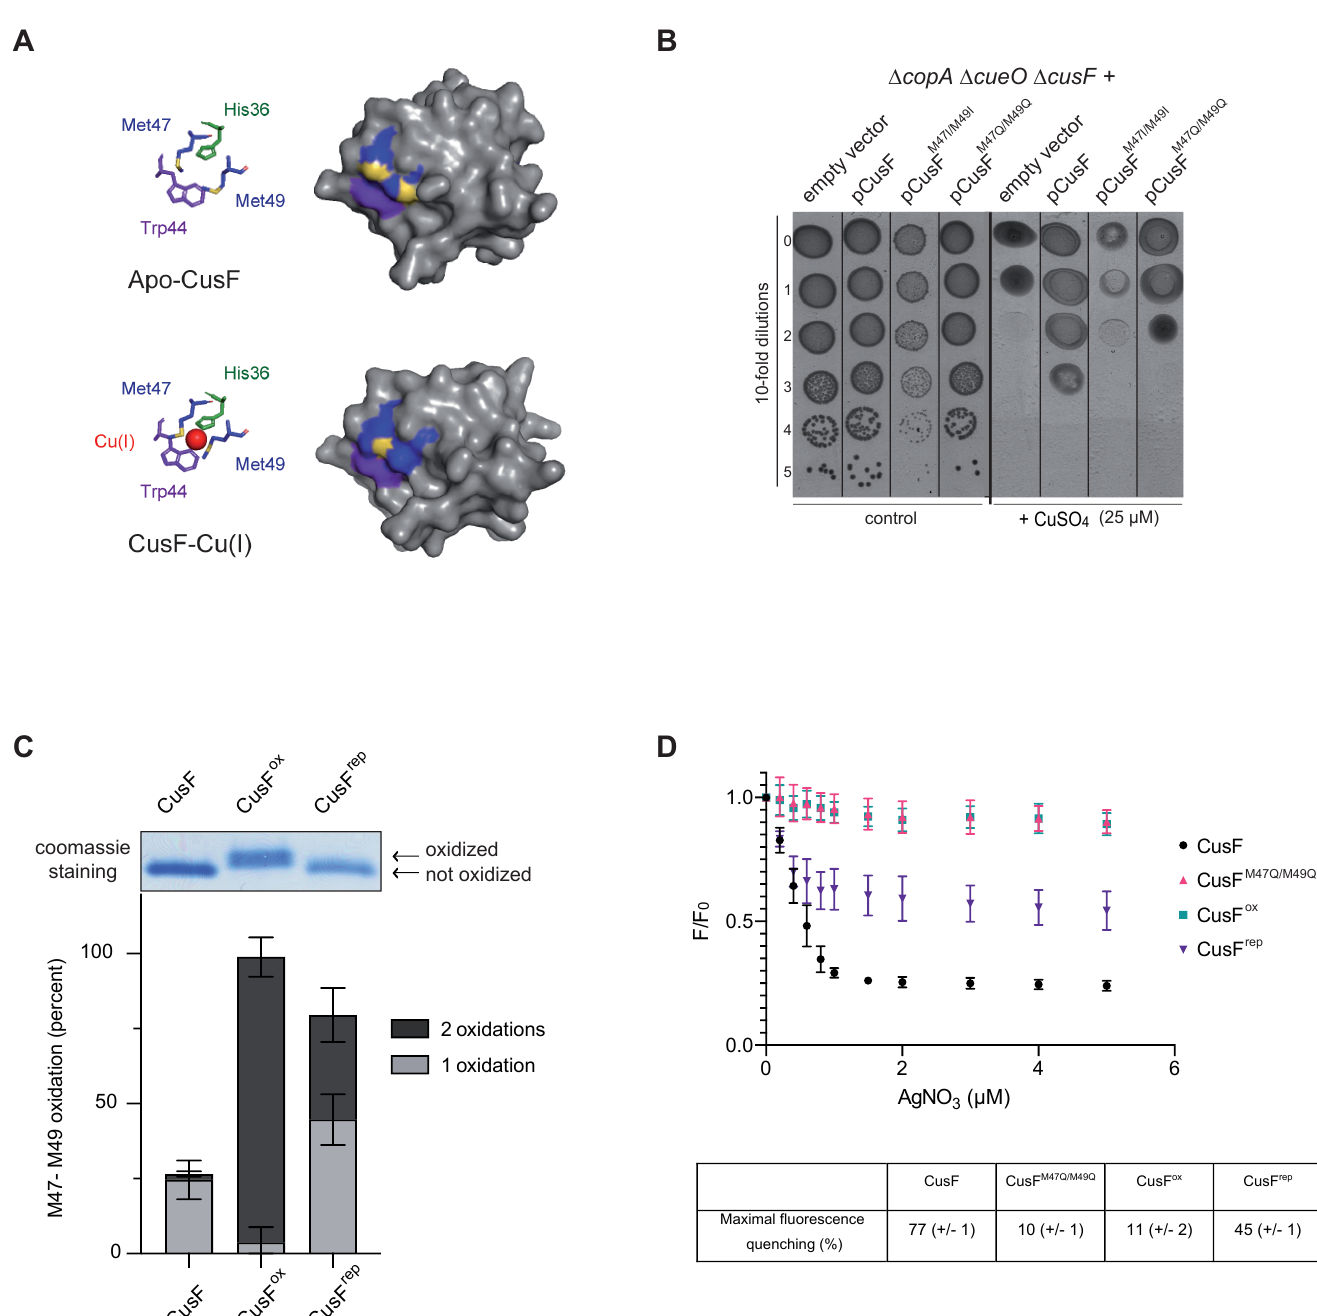
Fig 5. Methionine oxidation of CusF is deleterious. A) Aligned structures of the E . coli apo-CusF and CusF-Cu(I) adapted from PDB:1ZEQ and 2VB2 respectively [24,33] with stick and surface representations of CusF. Residues His 36 (green), Met 47, Met 49 (blue with sulphur atoms highlighted in yellow) and Trp44 (purple) are shown. The Cu(I) ion is shown in red. B) Plating efficiency of the Δ copA Δ cueO Δ cusF strain carrying empty vector, pCusF, pCusF M47I/M49I or pCusF M47Q/M49Q vectors onto M9 plates in the presence of CuSO 4 (25 μ M). The same protocol as described for Fig 2 was used, except plates contained ampicillin (50 μ g/ml) and IPTG (50 μ M). The images are representative of experiments carried out at least three times. C) Gel shift assay and mass spectrometry relative quantification by LFQ of the oxidation of Met47 and Met49. D) Silver binding analysed by quenching of intrinsic tryptophan fluorescence. Increasing concentrations of AgNO 3 (0, 0.2, 0.4, 0.6, 0.8, 1, 1.5, 2, 3, 4, and 5 μ M) were added to 1 μ M CusF, CusF M47Q/M49Q , CusF ox and CusF rep . The emission spectrum of CusF was recorded after each addition as described in the Materials and Methods. The integrated fluorescence peak (between 300 and 384 nm) in the presence of AgNO 3 (F) was compared with the peak obtained in its absence (F 0 ). The F/ F 0 ratio was plotted against the concentration of AgNO 3 , after correction for the inner filter effect of AgNO 3 measured on N - acetyltryptophanamide (NATA). The maximal fluorescence quenching for each variant of CusF was reported as a percentage in the